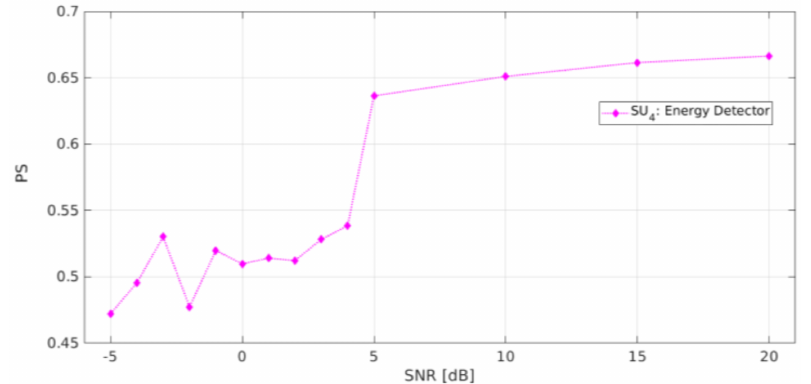
Figure 21. Probability of success of the energy detector.